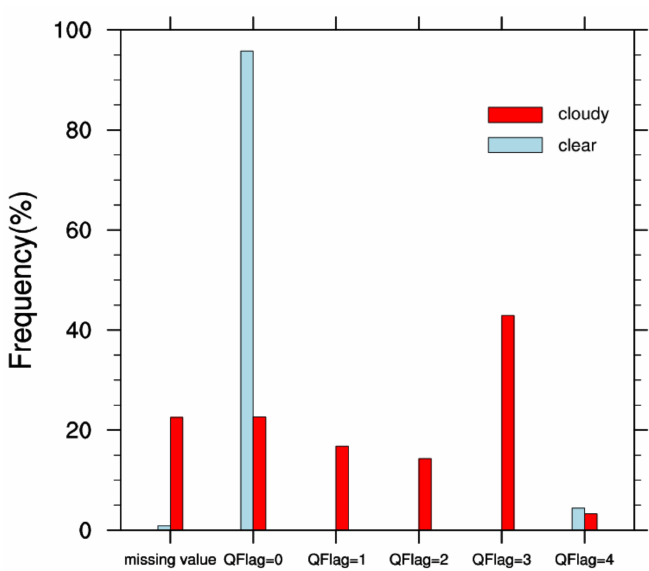
Figure 2. The occurrence frequency (%) with different quality flags (QFlag) from FY-4A GIIRS temperature profile product. The frequency is calculated under the cloudy sky (red bar) and clear sky (blue bar)